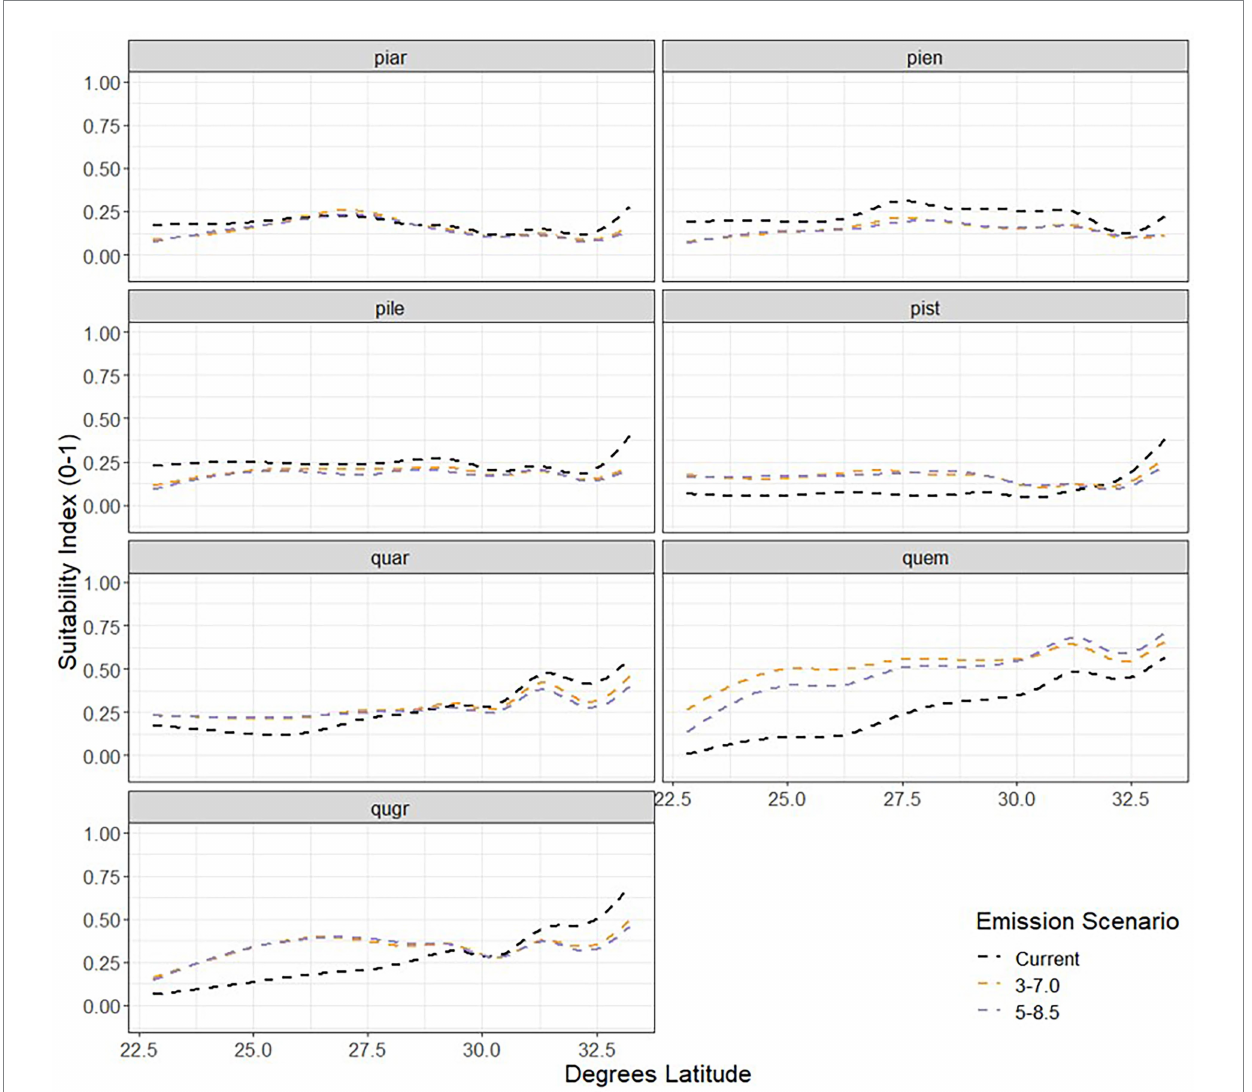
FIGURE 8 Comparison of the smoothed relationship between mean habitat suitability and latitude for the seven tree species of interest in the Coronado National Forest for current conditions (black, solid) and 2,100 estimates (colored, dashed) under different emissions